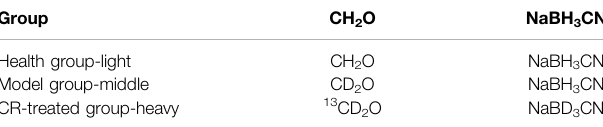
TABLE 1 | Isotope label grouping table. Group CH 2